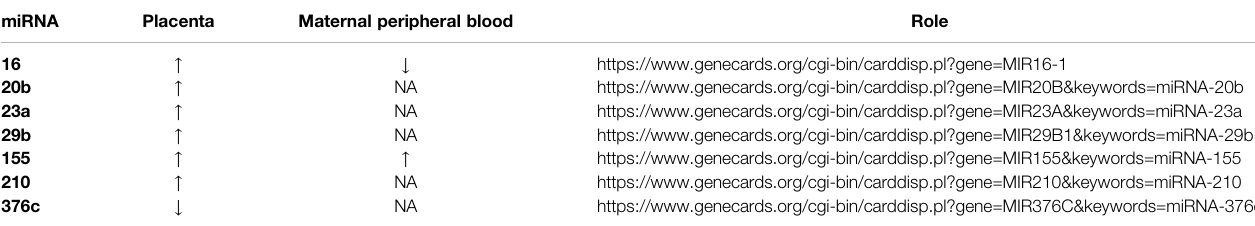
TABLE 2 | Functional roles of signi fi cant